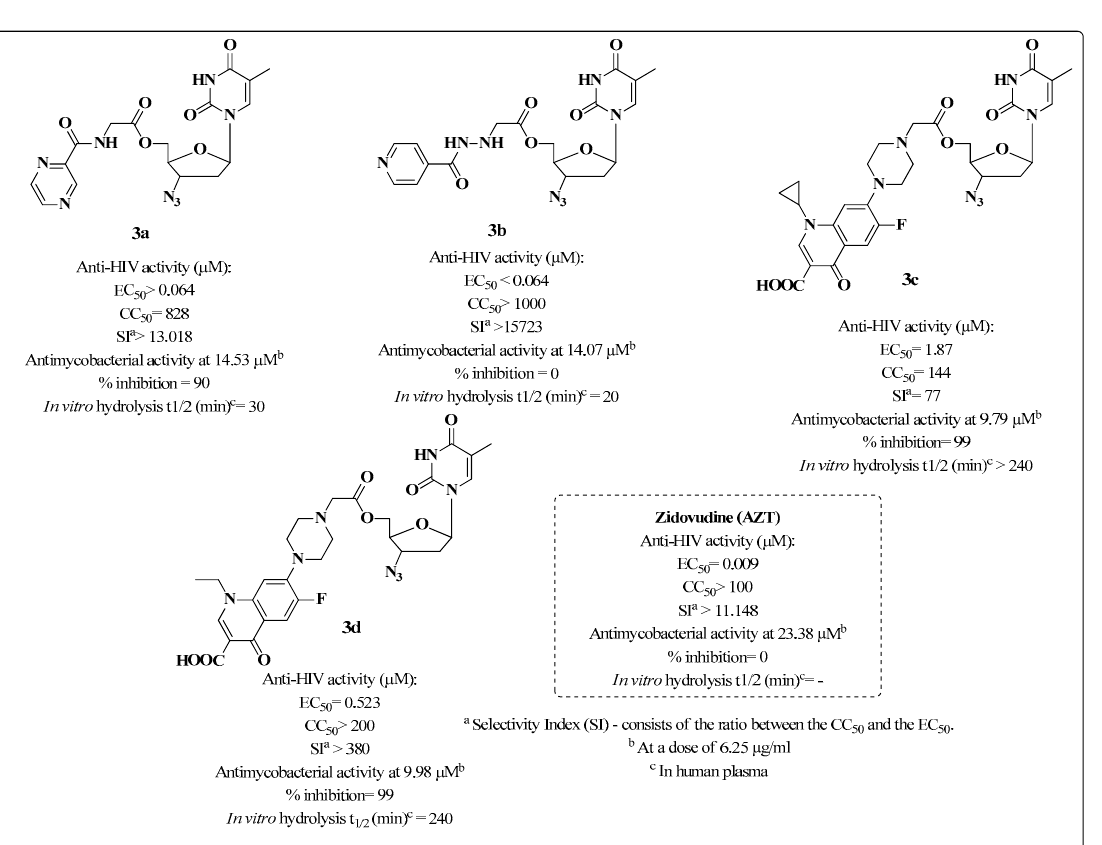
Figure 8. Biological activity (anti-HIV cells: MSC/anti-MTB cells: H 37 Rv) and stability of AZT derivatives synthesized by Sriram et al. in 2005 [80].